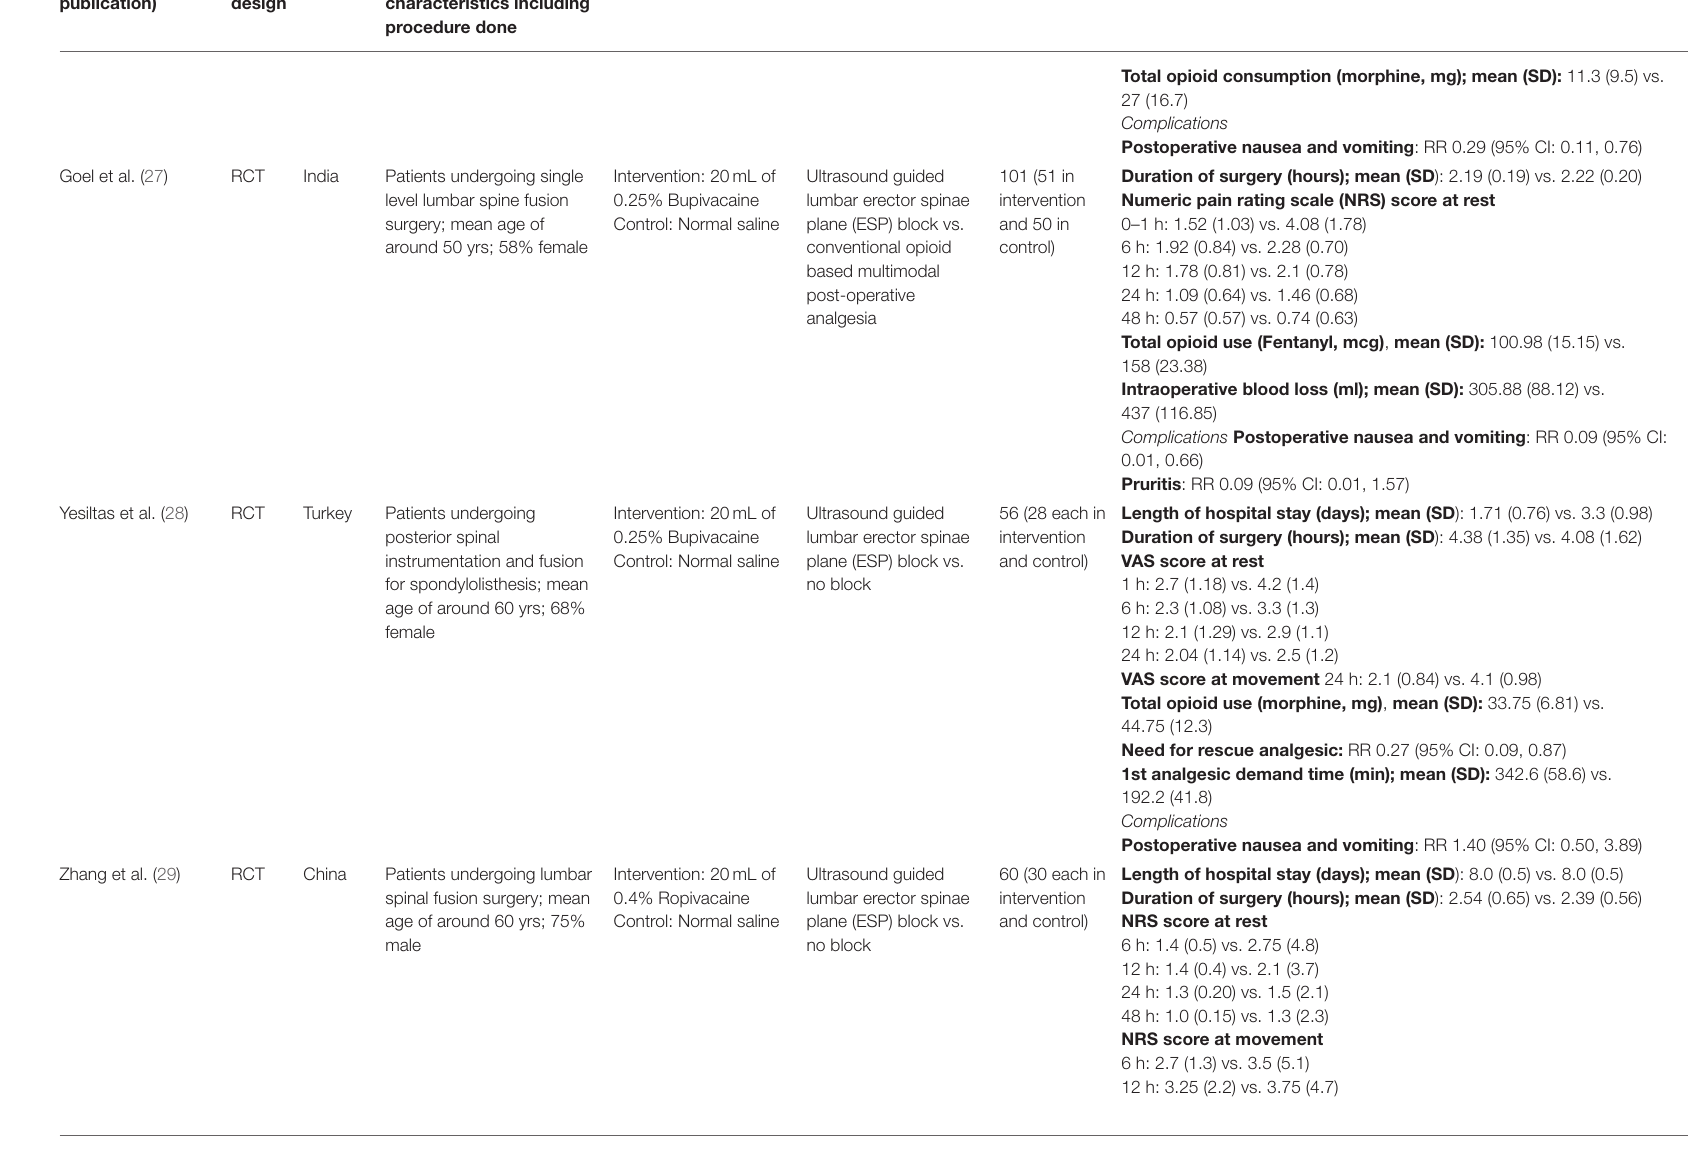
Comparator groups Sample size Key outcomes (compared to no block)